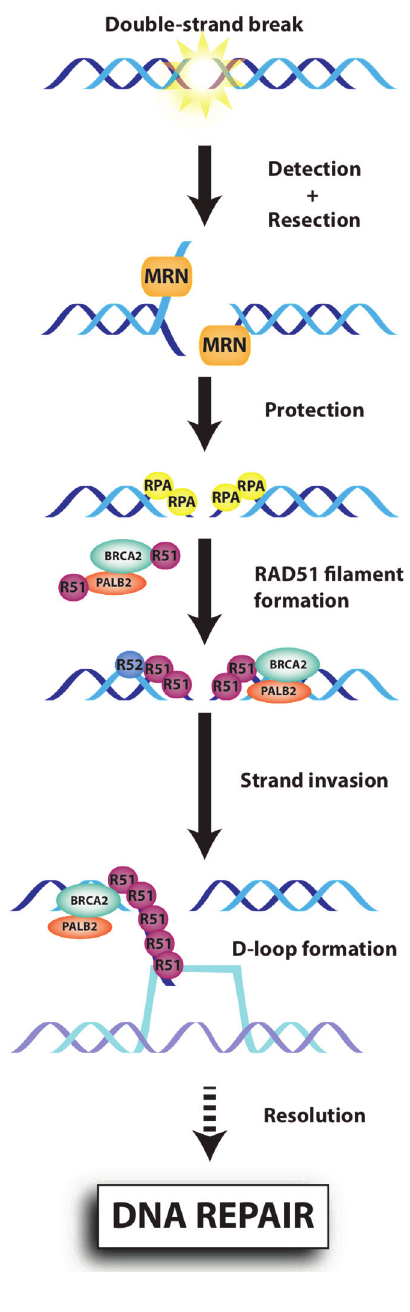
Figure 2. Schematic representation of DNA repair by homologous recombination. During Homologous Recombination (HR), the double-strand break is recognized by the MRE11-RAD50-NBS1 (MRN) (MRE11-RAD50-NBS1) complex, which resects DNA (with EXO1, CtIP and BLM) to create a 3'-overhang DNA that will be protected by RPA. The BRCA1-PALB2-BRCA2 complex then mediates the replacement of RPA by RAD51. RAD51 nucleoprotein filament, invades the complementary DNA template (a step called strand invasion), leading to the formation of the Displacement-loop (D-loop) structure. Following branch migration and resolution, faithful DNA repair